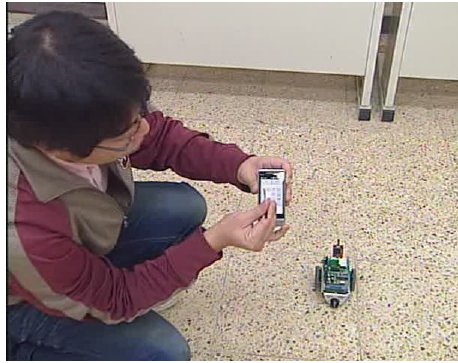
Figure 19. The testing environment of the second test based on smartphone control operation.